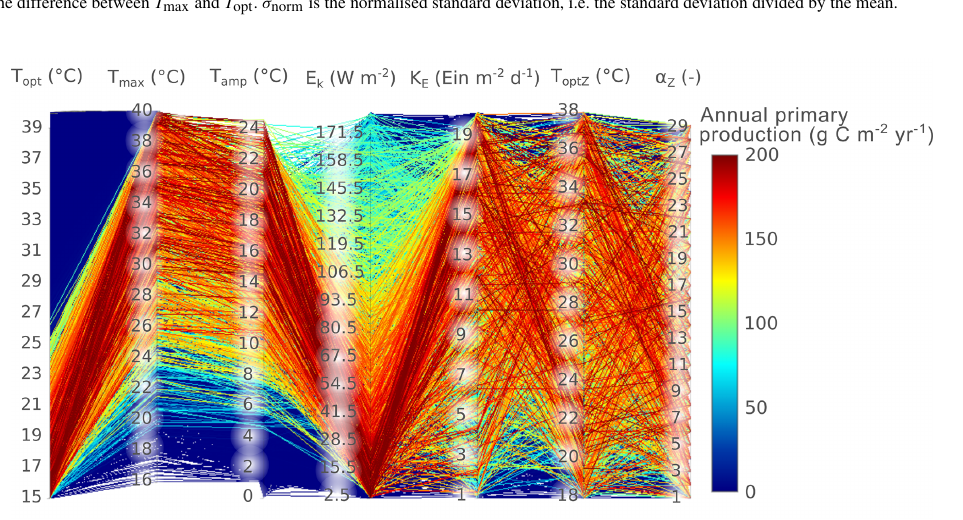
Figure 12. Parallel coordinates of the MPB annual primary production (gCm − 2 yr − 1 ) according to the temperature optimum for MPB growth ( T opt ), the temperature maximum for MPB growth ( T max ), the light saturation parameter ( E k ), the half-saturation constant for light use ( K E ), the temperature optimum for grazing by P. ulvae ( T opt ), and the shape parameter of the temperature grazing function ( α Z ) for Z 10000 combinations tested in the Monte Carlo sensitivity